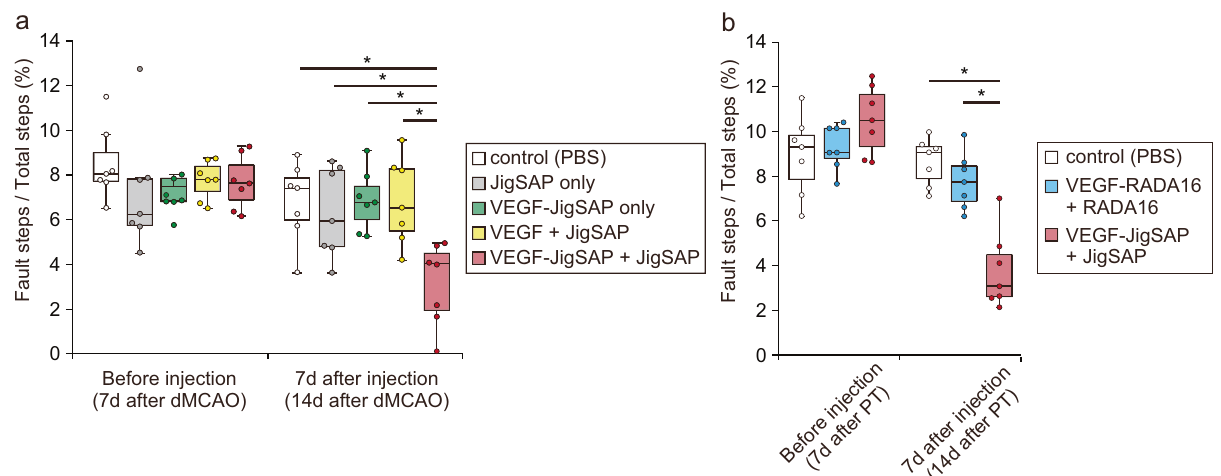
Fig. 6 Functional recovery of a mouse stroke model by a single injection of JigSAP nano fi bers incorporating VEGF-JigSAP proteins. Ratios of fault steps to total steps during FFT. a dMCAO model. b photothrombotic model. * P < 0.05 (Student ’ s t -test against VEGF-JigSAP + JigSAP, two-sided). n = 7. Box- plot elements show: center line, median; box limits, 25 and 75 percentiles; whiskers, (Q1/4 – 1.5IQR) and (Q3/4 – 1.5IQR). Source data are provided as a Source Data fi le. Abbreviations; dMCAO (distal middle cerebral artery occlusion), PT (photothrombotic model), PBS (phosphate buffered saline),